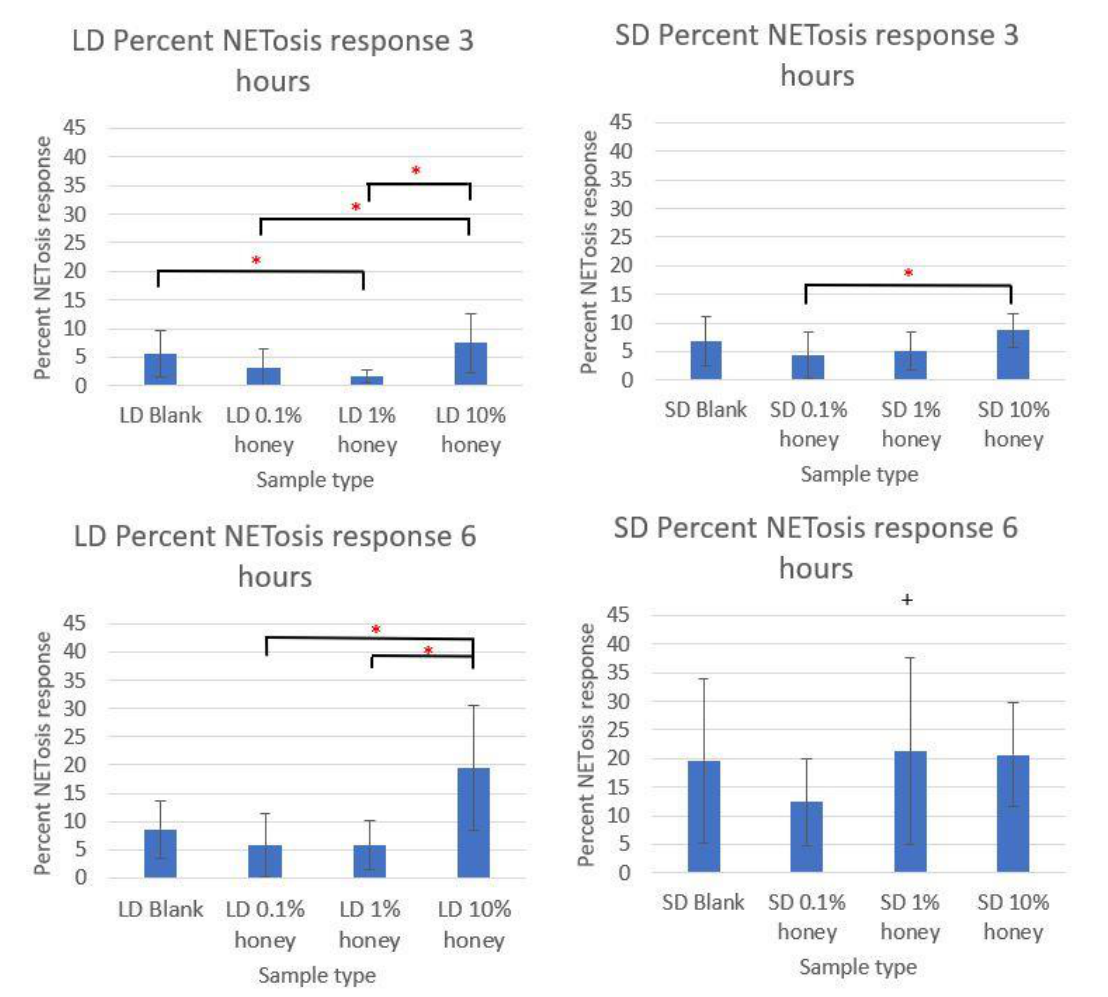
Figure 8. The 0.1% honey and 1% honey samples had the least NETosis response. The percent NETosis response, calculated from MPO concentration normalized to TCP 100 nM PMA positive controls, are shown on LD and SD templates at 3 and 6 h. * indicates a significant difference between the indicated samples within that template type and timepoint, while + indicates a significant difference from the respective LD template at that timepoint and honey level. Sample size of 4 replicates per timepoint per experiment, with 3 unique donor experiments. Raw data is available in Supplementary Spreadsheet 5.